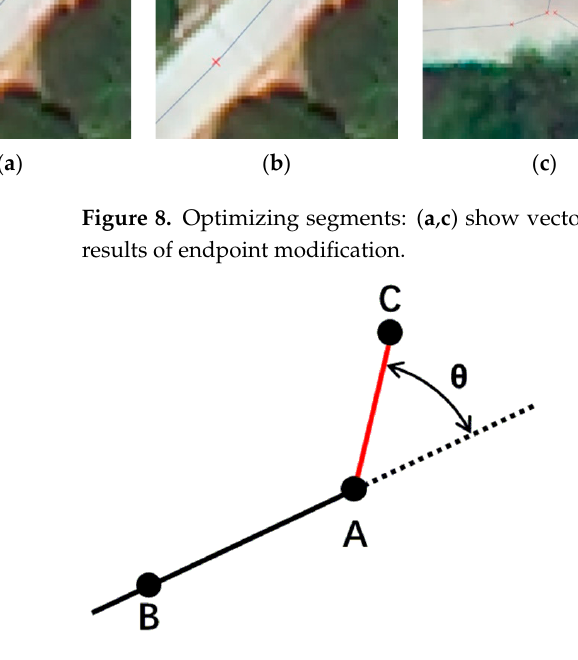
Figure 9. Endpoint modification.